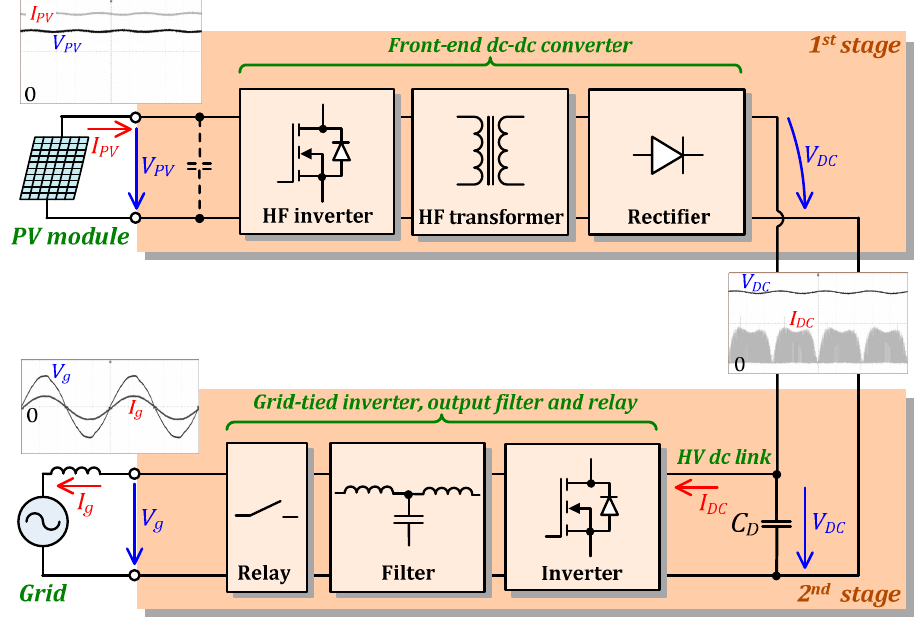
Energies 2019 , 12 , x Figure 1. Generalized structure of a two-stage PV microinverter. Figure 1. Generalized structure of a two-stage PV microinverter.